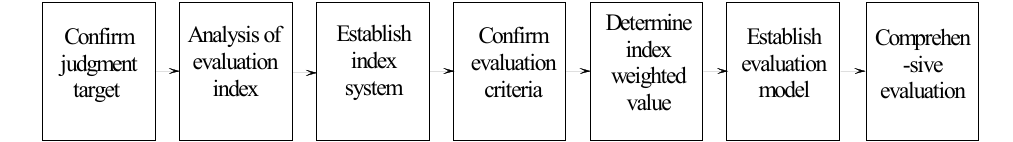
Figure 1. Steps of the fuzzy comprehensive evaluation method.